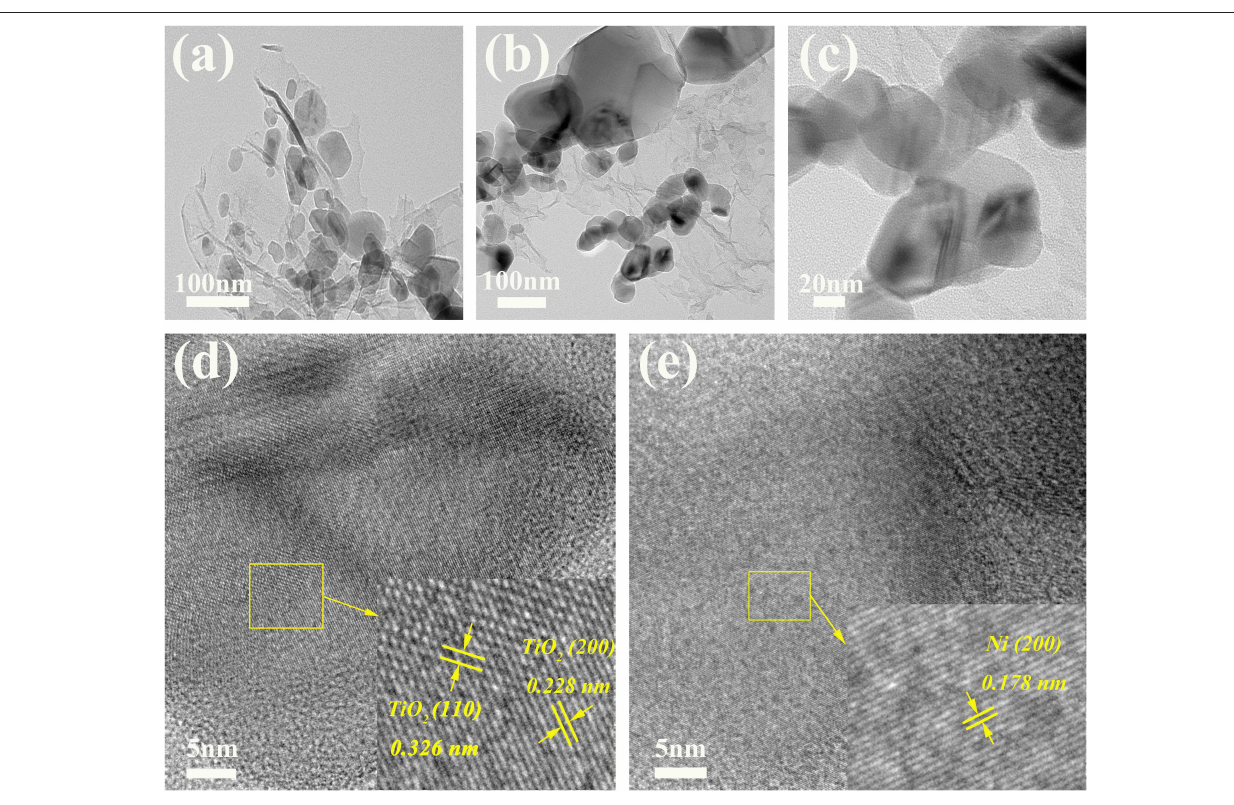
Frontiers in Chemistry |